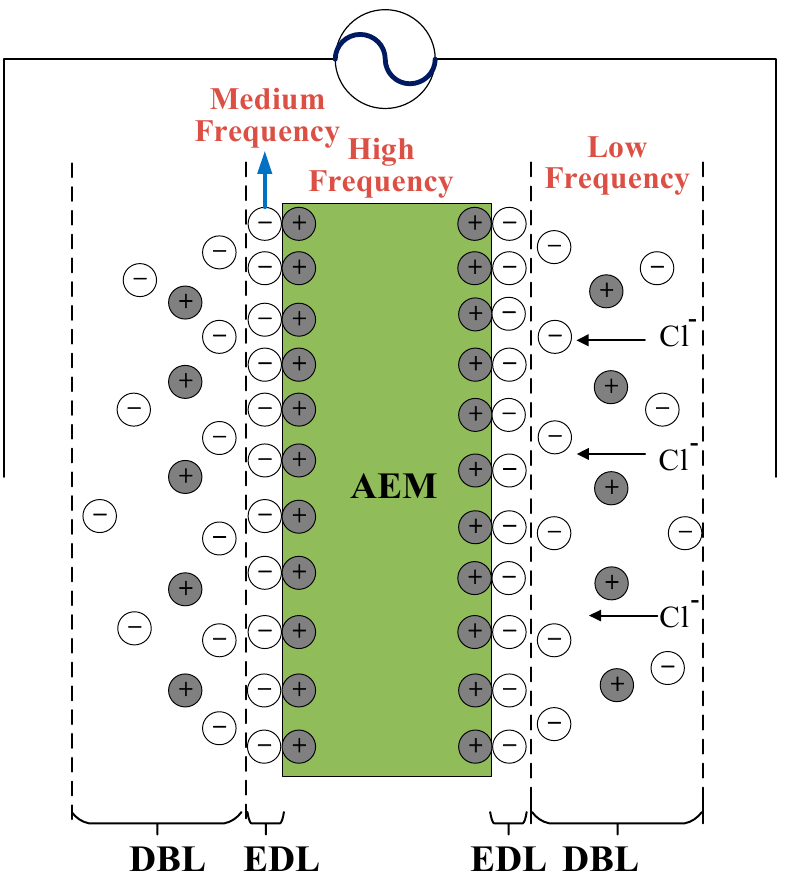
Figure 1. Schematic diagram of an AEM with the diffusion boundary layer (DBL) and electrical double layer (EDL) formed in a sodium chloride solution operated with alternating current. Membrane resistance can be measured at a high frequency. The EDL resistance can be obtained at the medium frequency, while the DBL resistance can be obtained at low frequencies.